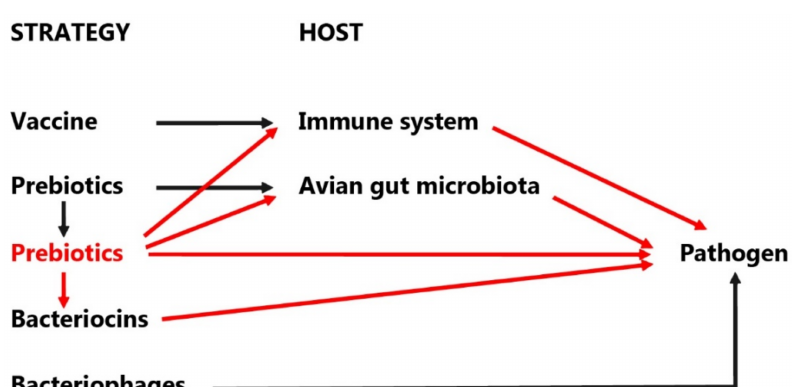
Figure 1. Potential pathways of the strategies in progress to reduce avian gut pathogens. Red arrows represent probiotic pathways